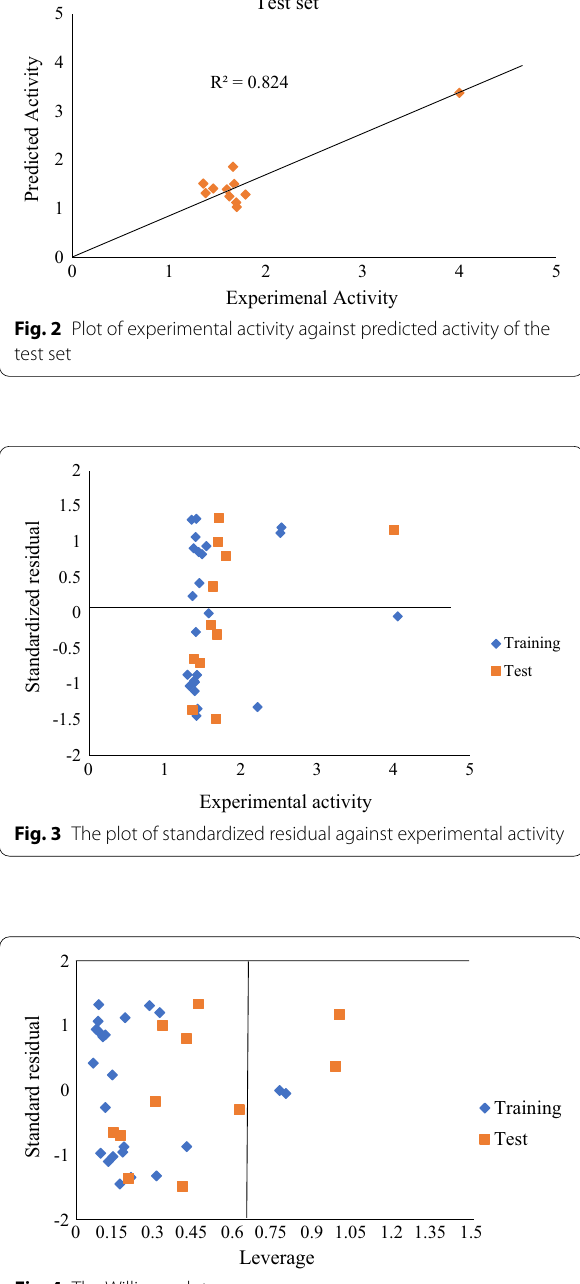
Fig. 4 The Williams plot